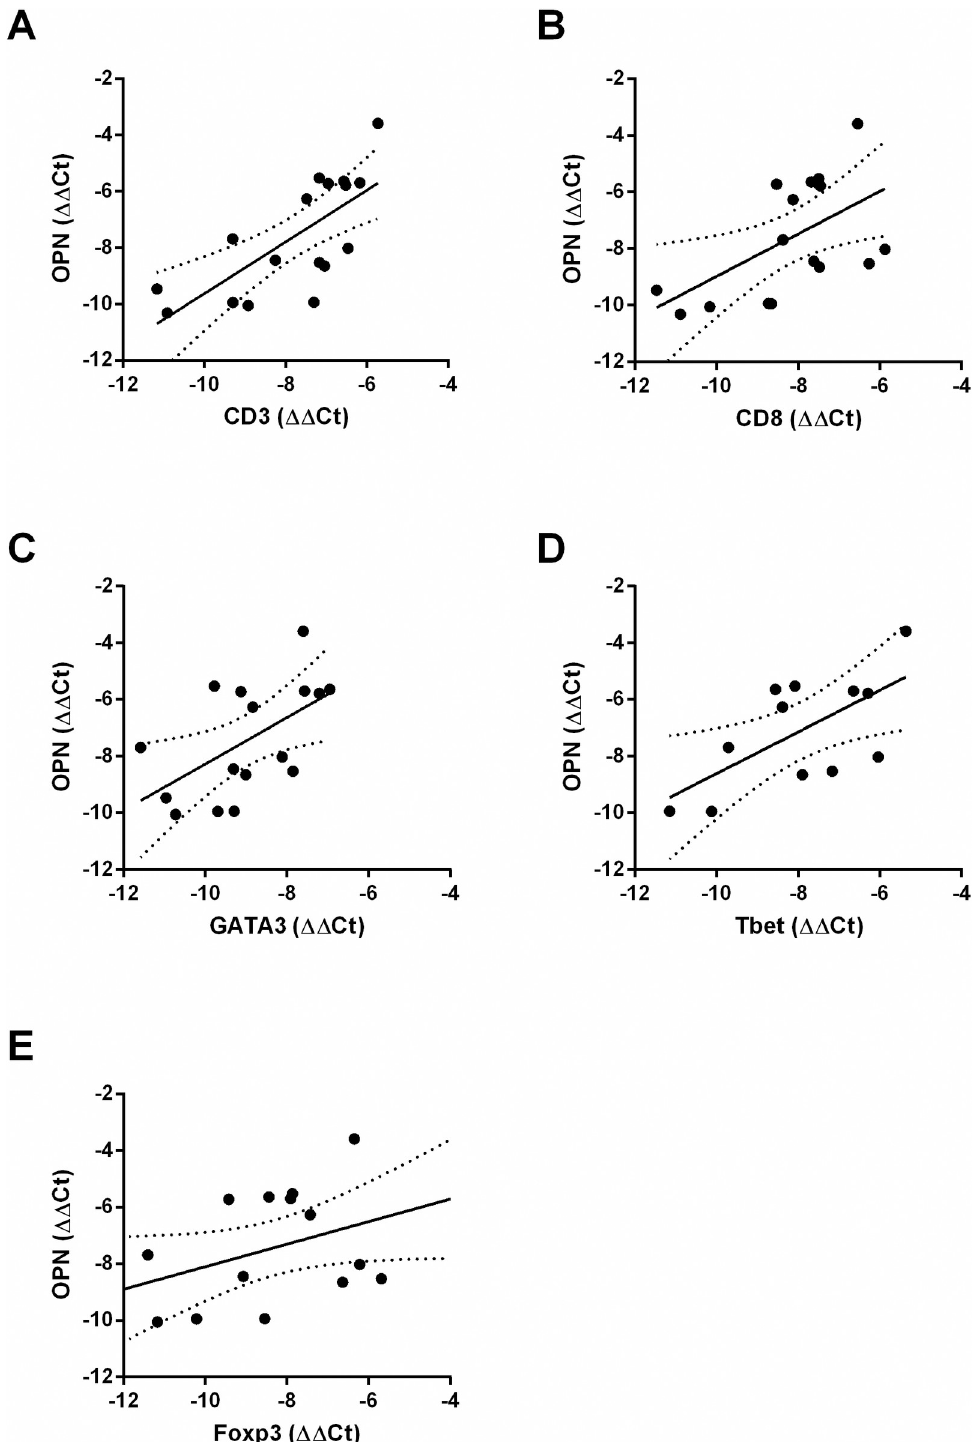
Fig 3. CD3, CD8 and GATA3 correlate significantly with OPN gene expression in human adipose tissue. Omental adipose tissue from individuals with obesity was isolated and (A) CD3 and OPN gene expression were analyzed by RT-PCR (n = 17) Spearman coefficient: r = 0.723, p = 0.0005 (B) CD8 and OPN gene expression (n = 17): r = 0.5637, p = 0.0203; (C) GATA3 and OPN gene expression (n = 16): r = 0.5206, p = 0.04; (D) Tbet and OPN (n = 12): r = 0.4825, p = 0.1154; (E) Foxp3 and OPN (n = 16): r = 0.3971, p = 0.1289; � p < 0.05, �� p < 0.01, ��� p < 0.001 and ���� p < 0.0001. Best fit line as well as the 95% confidence interval are indicated by lines in the graphs. https://doi.org/10.1371/journal.pone.0214938.g003 PLOS ONE | https://doi.org/10.1371/journal.pone.0214938 April 5,